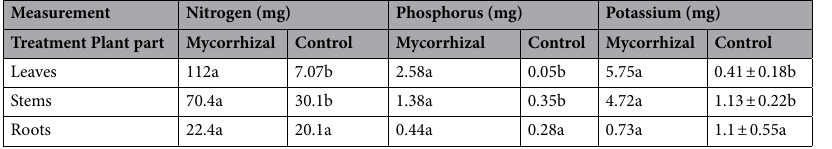
Table 5. Nutrient accumulation in the roots, stems and leaves of peanut. Nutrients accumulated in each plant part (mg) = concentration of nutrient in each plant part (mg kg -1 ) × dry weight of the plant part (g) × 10 –3 ; within each nutrient, mean values not followed by the same letter are significantly different by LSD ( p < 0.05).